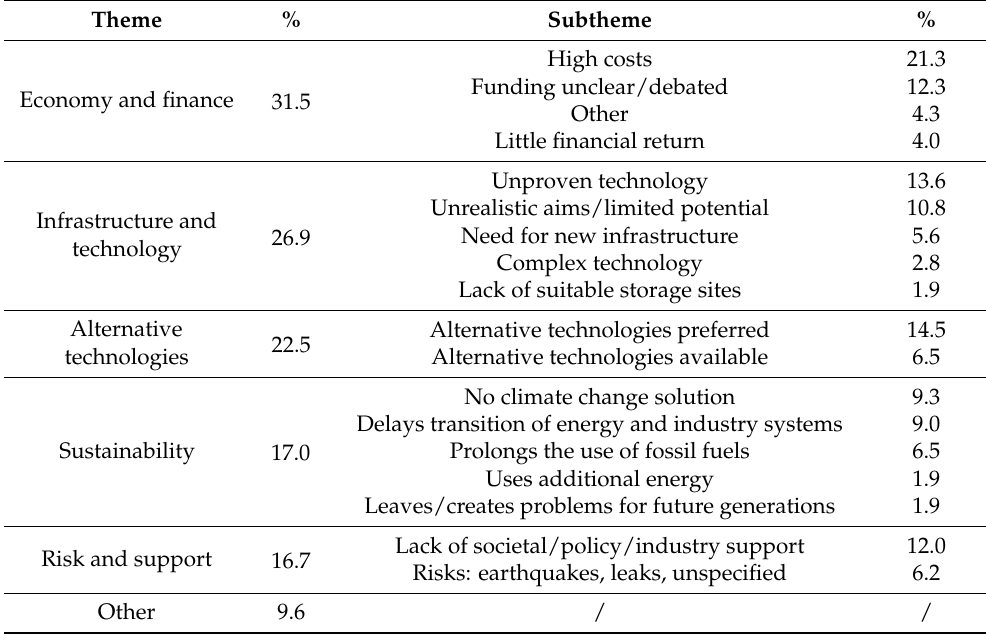
Table 3. Arguments against CCS: (sub)themes and the proportion of articles that use at least one argument within each (sub)theme ( n = 324